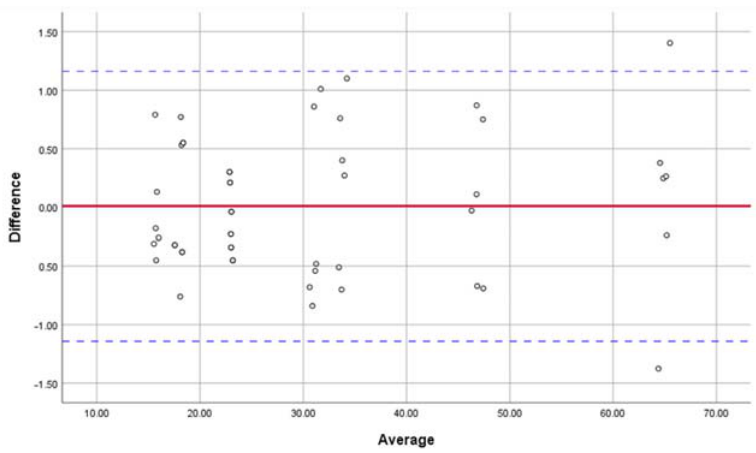
Figure 7. Bland–Altman plot analysis was used for investigating the inter-observer agreement in